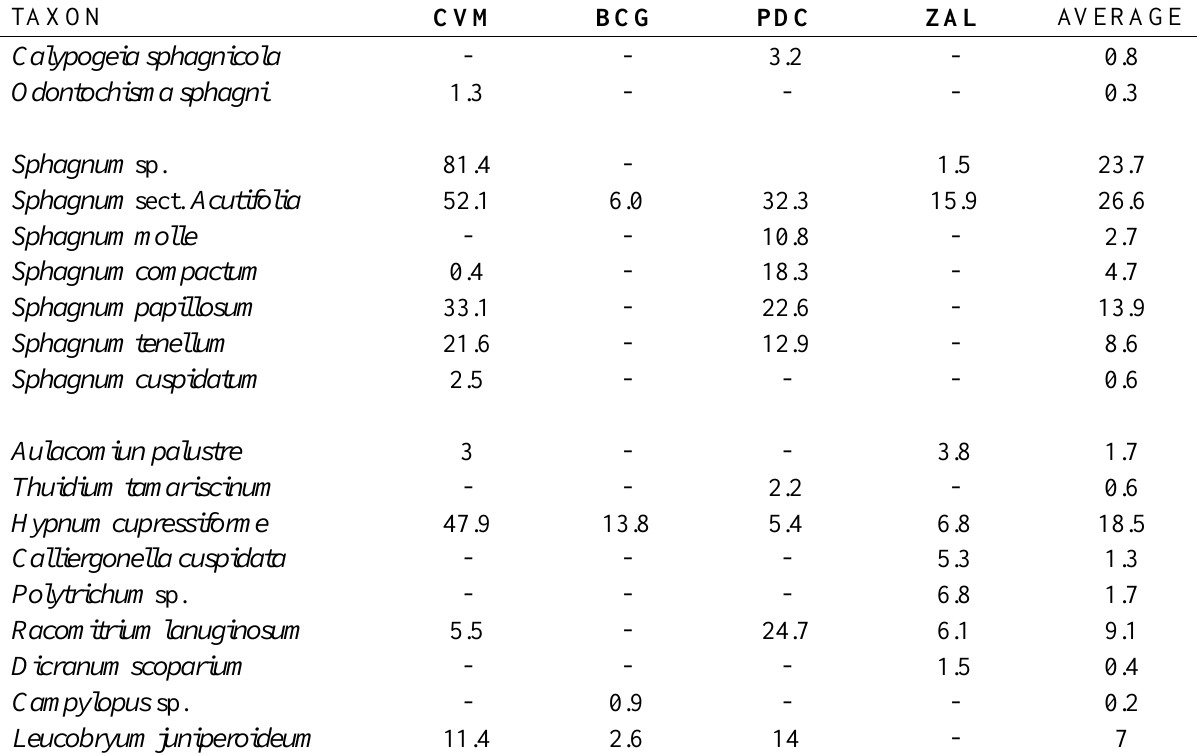
Table 1. Relative frequencies (%) of the bryophyte macrofossils identified for each core series of the sampled bogs (CVM: Chao de Veiga Mol; BCG: Borralleiras de Cal Grande; PDC: Pena da Cadela; ZAL: Zalama) and for all sampled bogs